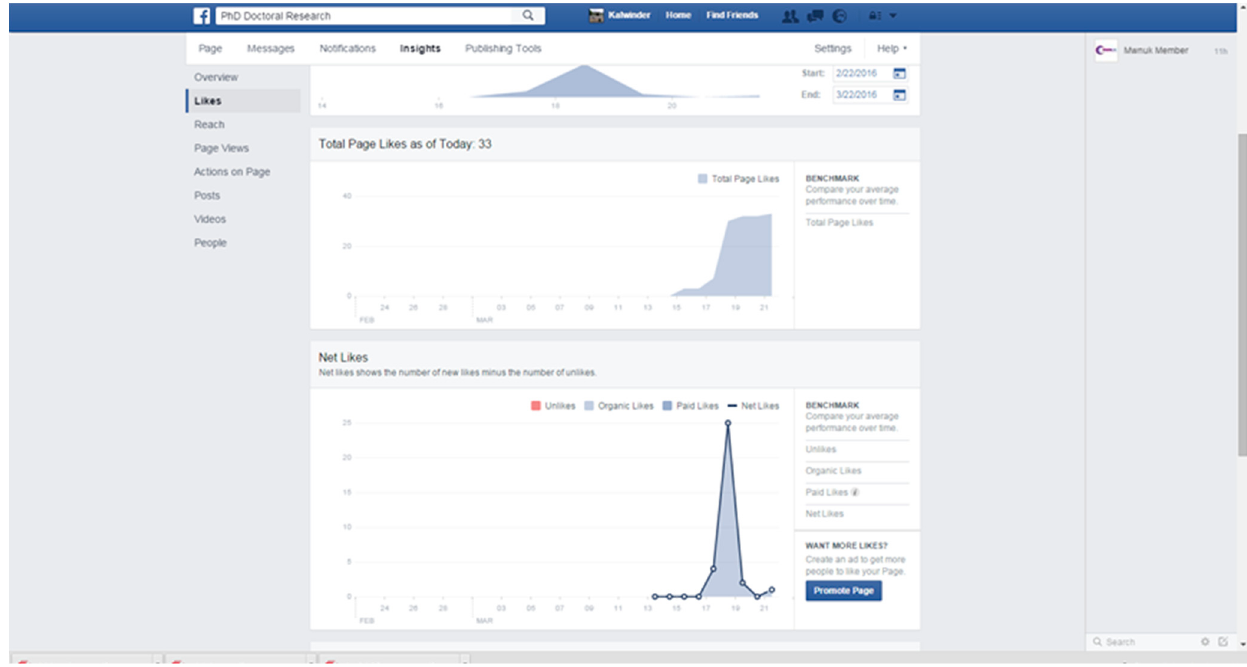
Figure 1. Number of ‘likes’ of the page when it was first created.